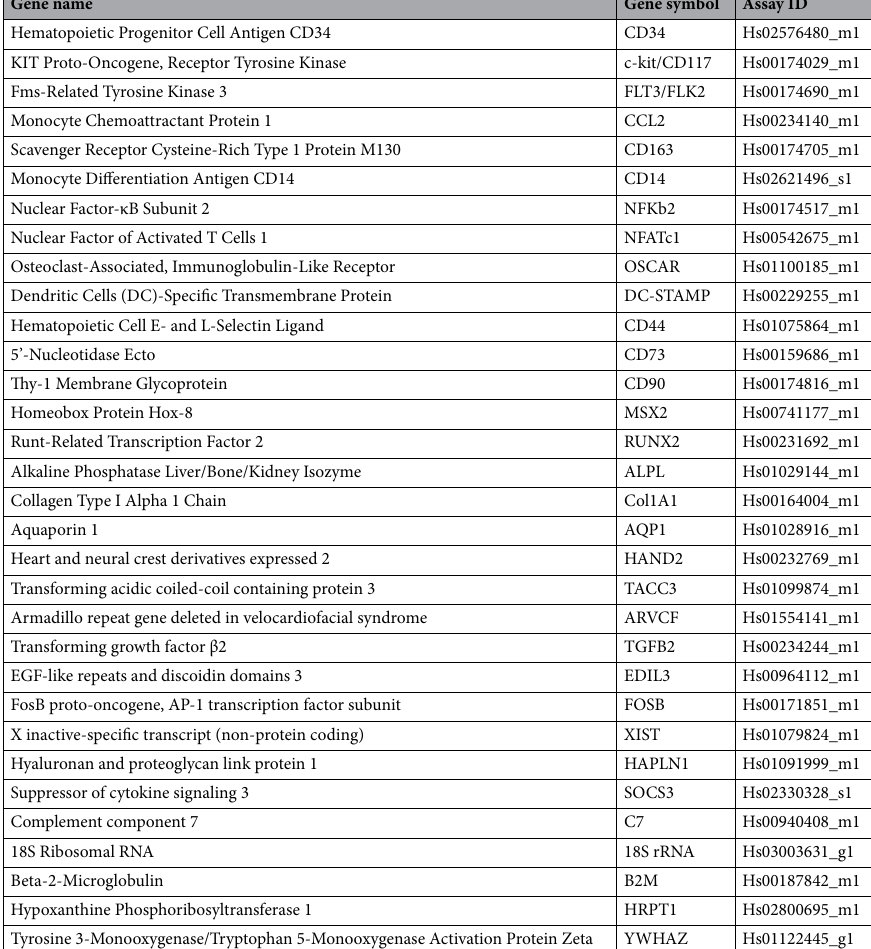
Table 2. Overview of markers used for the gene expression analysis to verify differentiation within the hematopoietic lineage or mesenchymal lineage and the top (up- and down-regulated) differentially expressed genes detected in the next generation RNA sequencing analysis of osteoprogenitor cells from responders and non-responders to supraphysiological